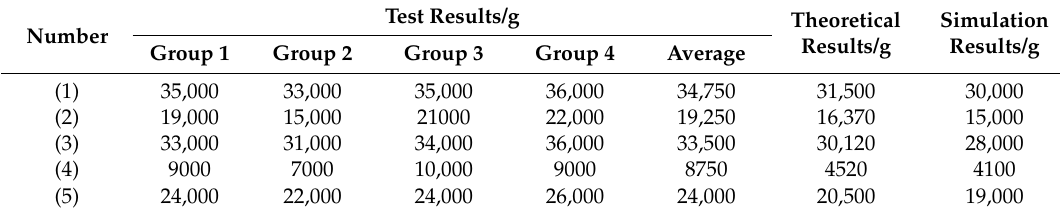
Table 5. The g-value of the delaying mechanism with different parameters.